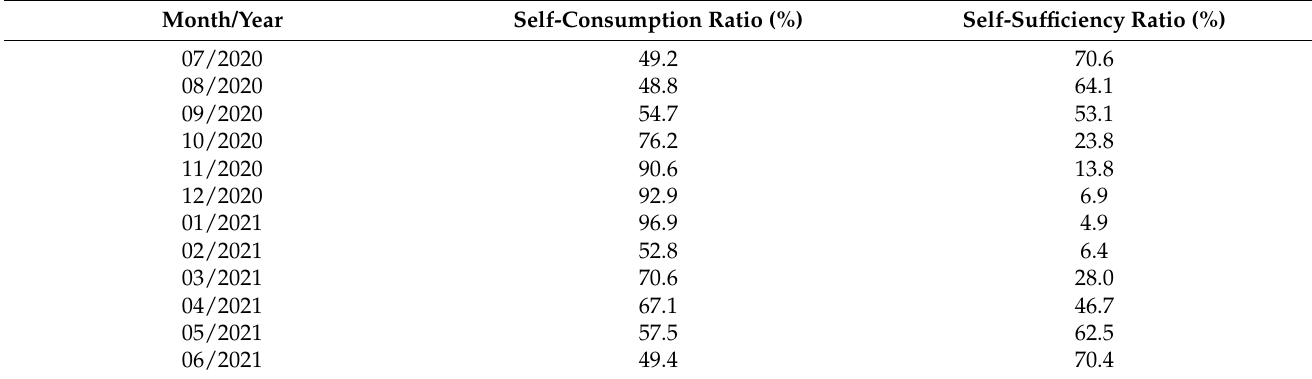
Table 6. Summary of self-consumption and self-sufficiency obtained by the PV9 system.